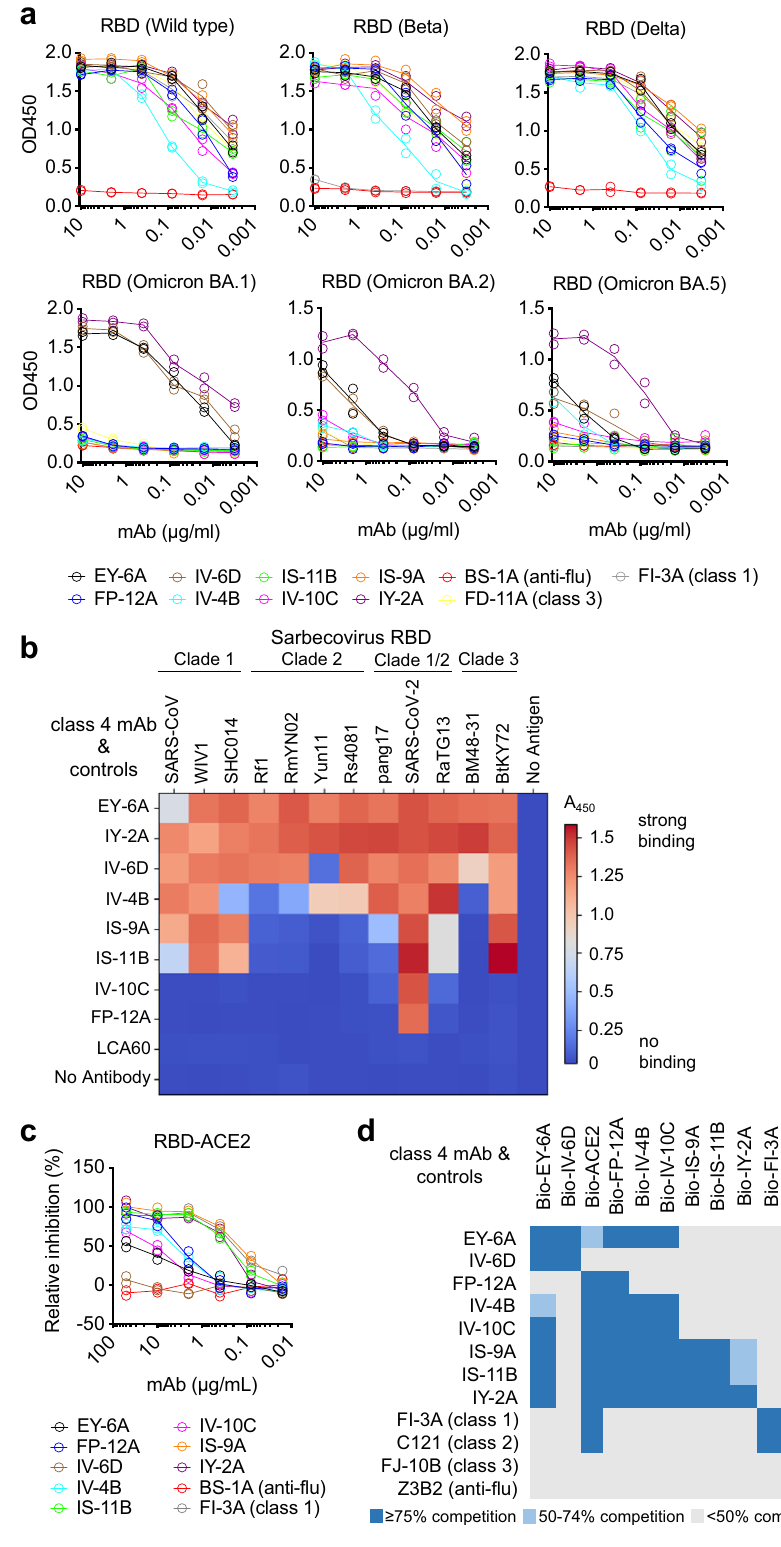
All of the class 4 antibodies were assessed for neutralization potency using a SARS-CoV-2 pseudotyped virus assay. The antibodies showed varied levels of neutralizing potency against wild-type